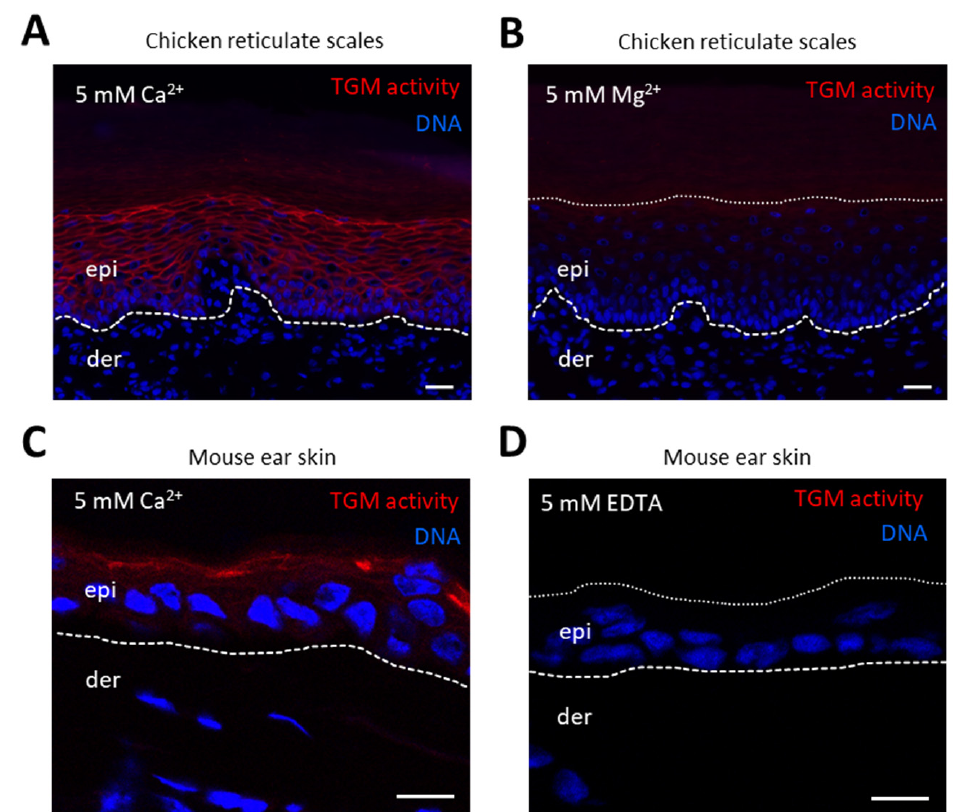
Figure 3. In situ labeling of transglutaminase (TGM) activity in chicken reticulate scales and mouse skin. Reticulate scales from an adult chicken ( A , B ) and mouse ear skin ( C , D ) were cryosectioned and incubated with Alexa-fluor 555-cadaverine (red) in buffer containing either calcium ( A , C ), magnesium ( B ) or EDTA ( D ). Nuclear DNA was labeled with Hoechst 33258 (blue). The images were recorded with an Olympus BX63 microscope ( A , B ) and a Zeiss 980 confocal laser scanning microscope ( C , D ). White dashed lines indicate the lower border of the epidermis ( A – D ) and white dotted lines indicate the upper border of the epidermis in images of samples incubated with magnesium ( B ) and EDTA ( D ). Scale bars = 20 µm ( A , B ), 10 µm ( C , D ).